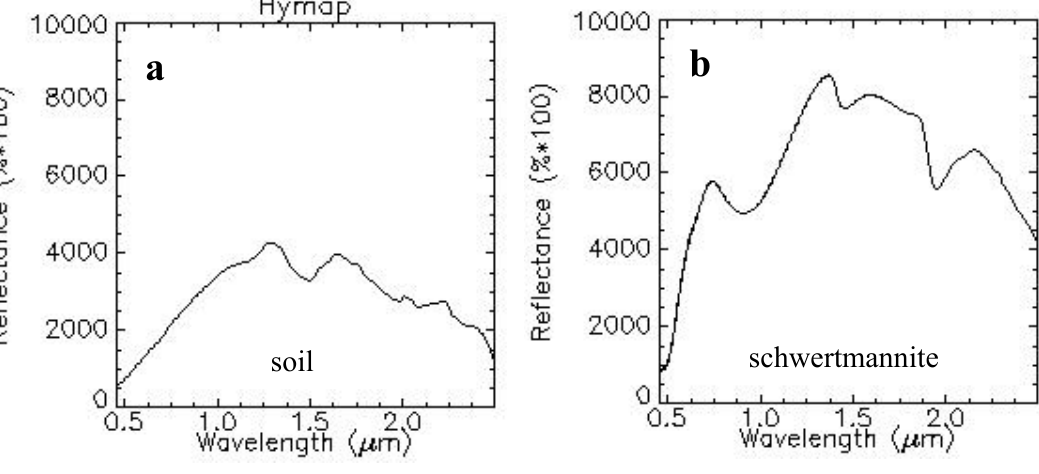
Figure 4. (a) Spectra from soil over the host rock extracted from Hymap data (b)